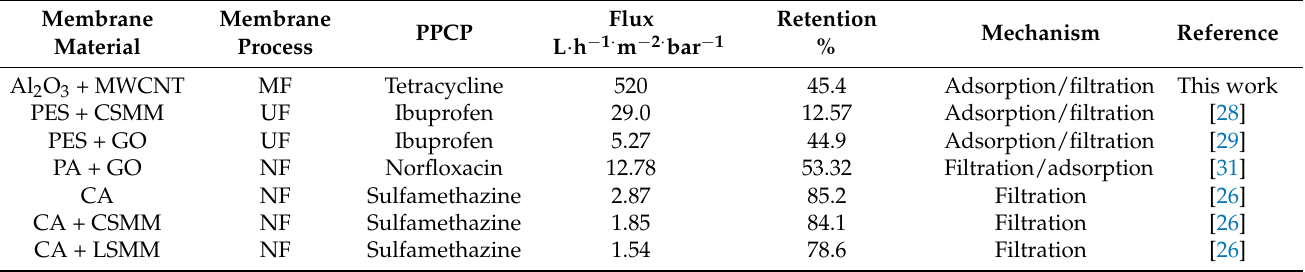
Table 4. PPCP removal by